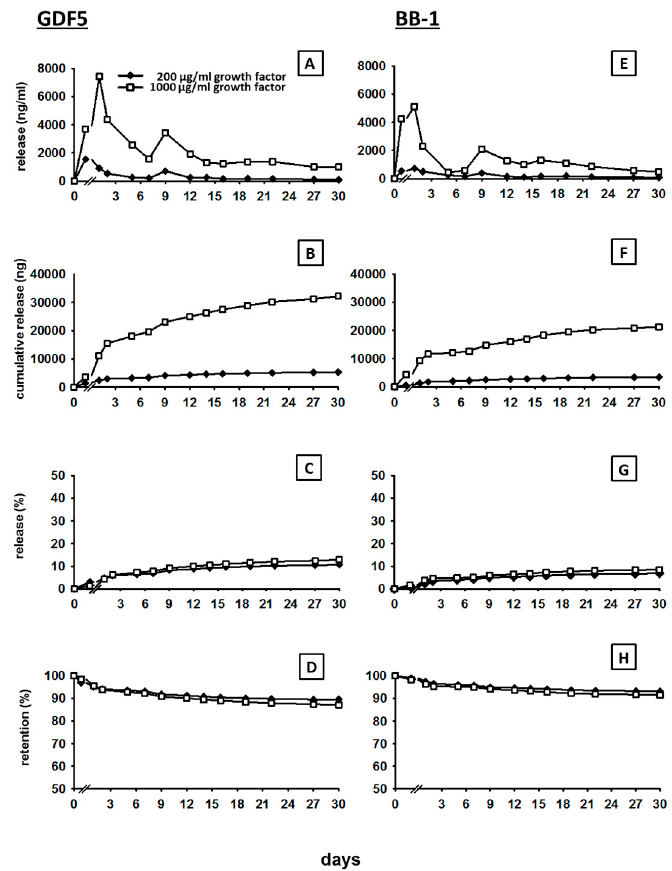
Figure 2. In vitro release of 200 and 1000 µ g / mL GDF5 and BB-1 from CPC. Cement cuboids ( l = 10 mm, h = 5.0 mm, w = 5.0 mm, V = 250 µ L) were loaded with 200 or 1000 µ g / mL GDF5 and BB-1, ground, and incubated at 37 ◦ C in 2 mL of either PBS or sheep serum. After 1 h, as well as 1, 2, 5, 7, 9, 12, 14, 16, 19, 22, 27, and 30 days, the release of GDF5 ( A ) and BB-1 ( E ) from ground cement discs was measured by ELISA and used for the calculation of cumulative release ( B , F ), % release ( C , G ), and retention ( D , H ; n = 1).